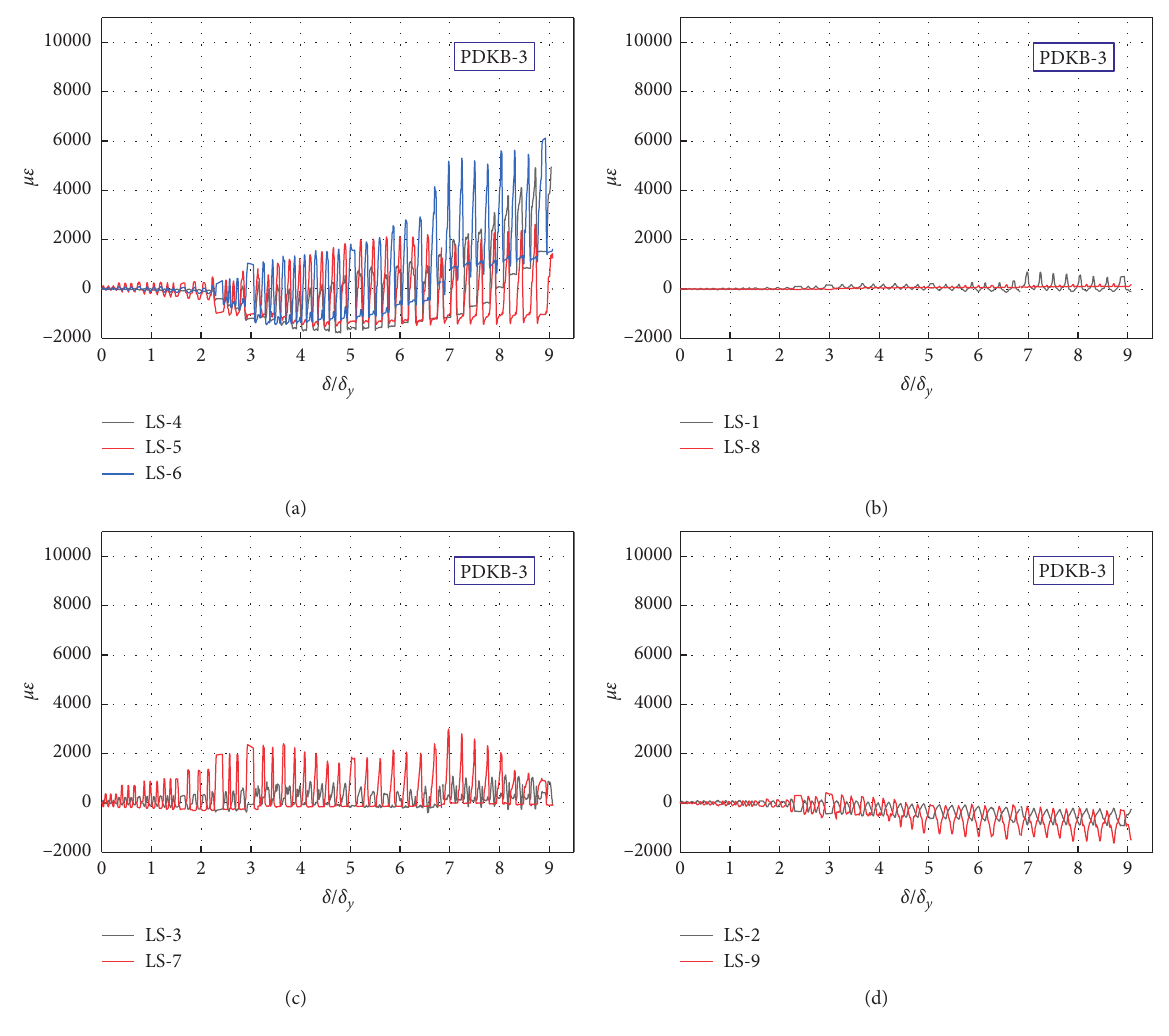
Figure 29: Strain of bolts of specimen PDKB-3. Table 14: Maximum strain of bolts.